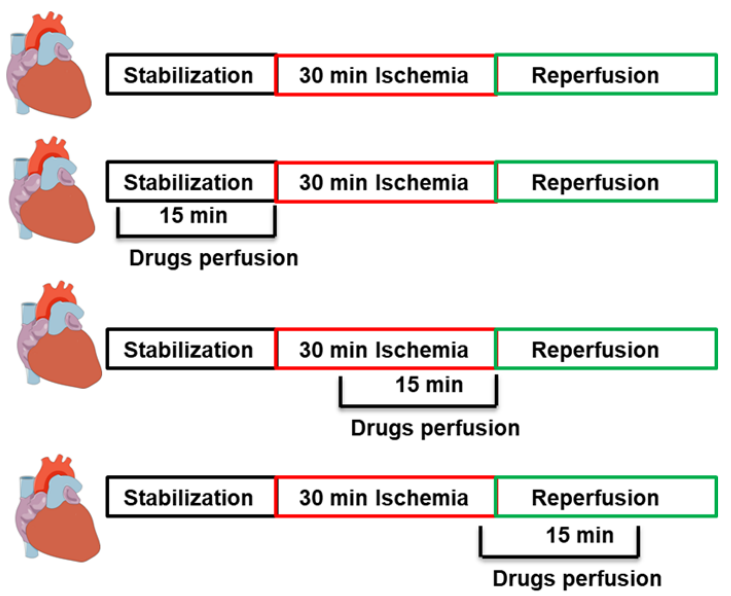
Figure 9. Schematic illustration showing the treatment protocols. Infusion of drugs before ischemia, during ischemia, or at reperfusion for 15 min each.